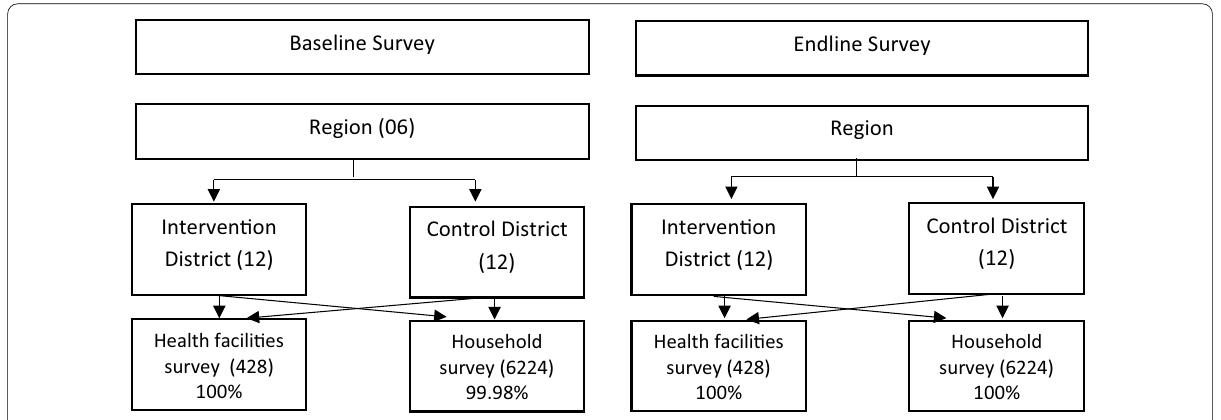
Fig. 1 Survey design